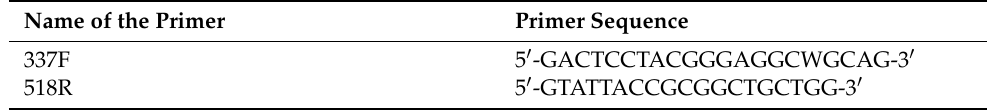
Table 1. The primers used in the study.